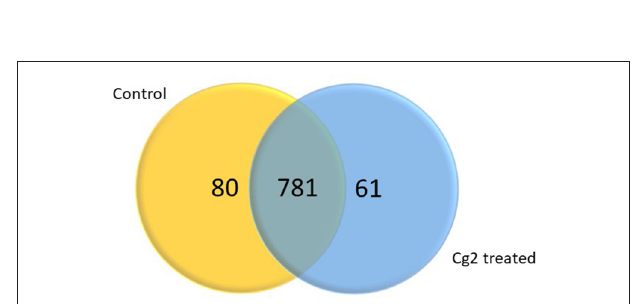
FIGURE 4 | Venn diagram showing the differentially expressed genes (DEGs) significantly expressed exclusively in control plant, Cg-2 treated plant and mutually expressed in both conditions. (Fold change < -2 or > 2 and P <